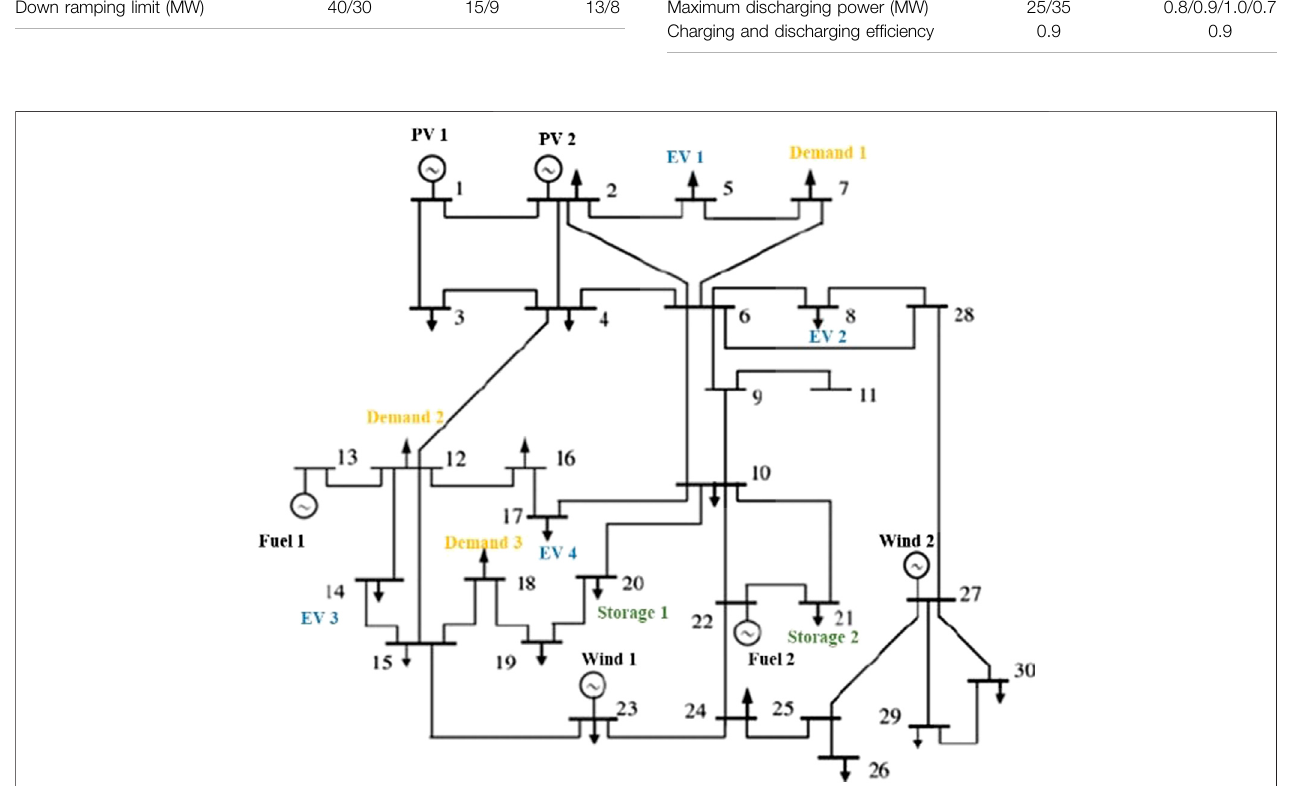
FIGURE 4 | Modi fi ed IEEE-30 bus system.